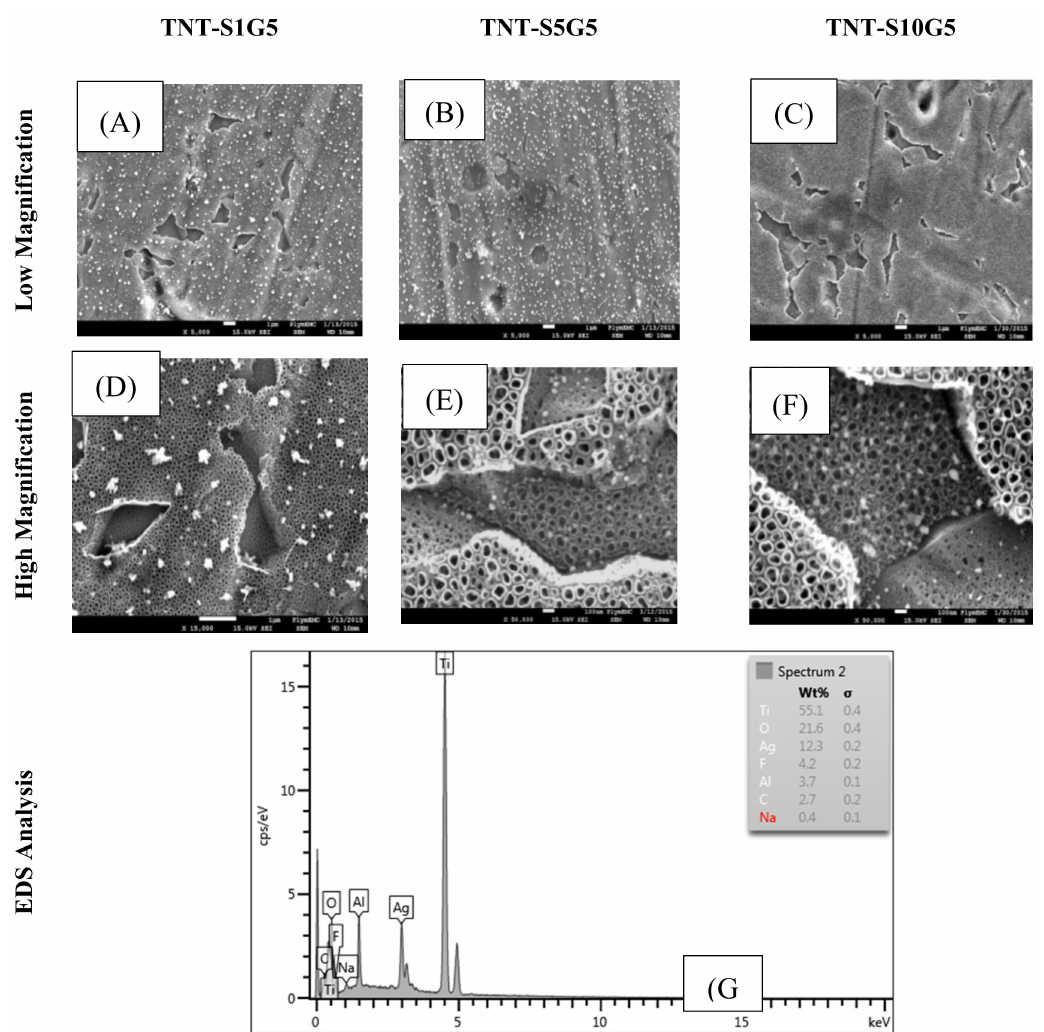
Figure 7. SEM images of nanoclusters of silver nanoparticles grown by using 0.015 M Silver Ammonia and 0.002 M δ -gluconolactone and the exposure time to silver ammonia being ( A ) 1 min, ( B ) 5 min and ( C ) 10 min and exposure to G being 5 min. ( D – F ) Higher magnification SEM images of TNT-S1G5, S5G5 and S10G5, respectively. ( G ) EDS analysis of the silver nanoparticles-coated TNT. (Reproduced with permission from Gunputh et al., Anodised TiO2 nanotubes as a sca ff old for antibacterial silver nanoparticles on titanium implants; published by Elsevier, 2018,